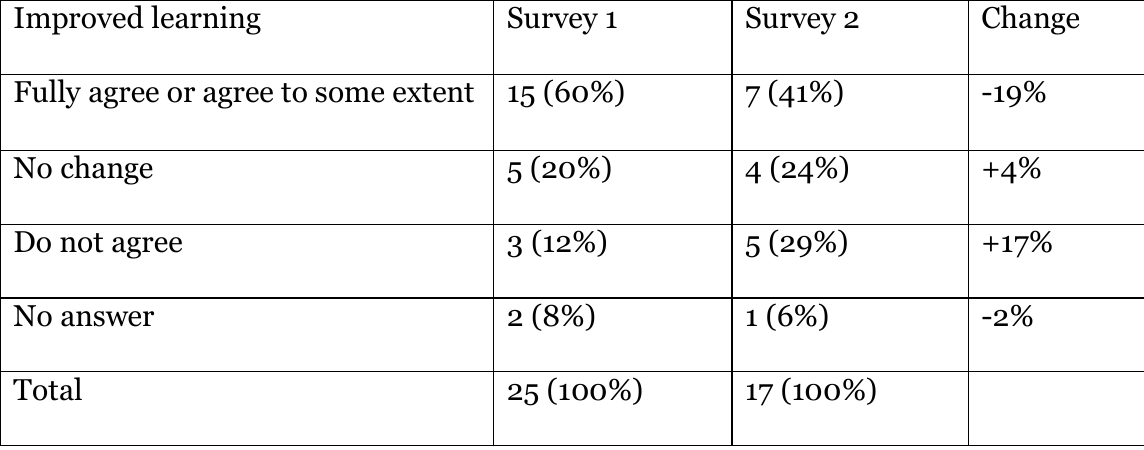
Table 1 Parents’ Perceptions of improved learning for children